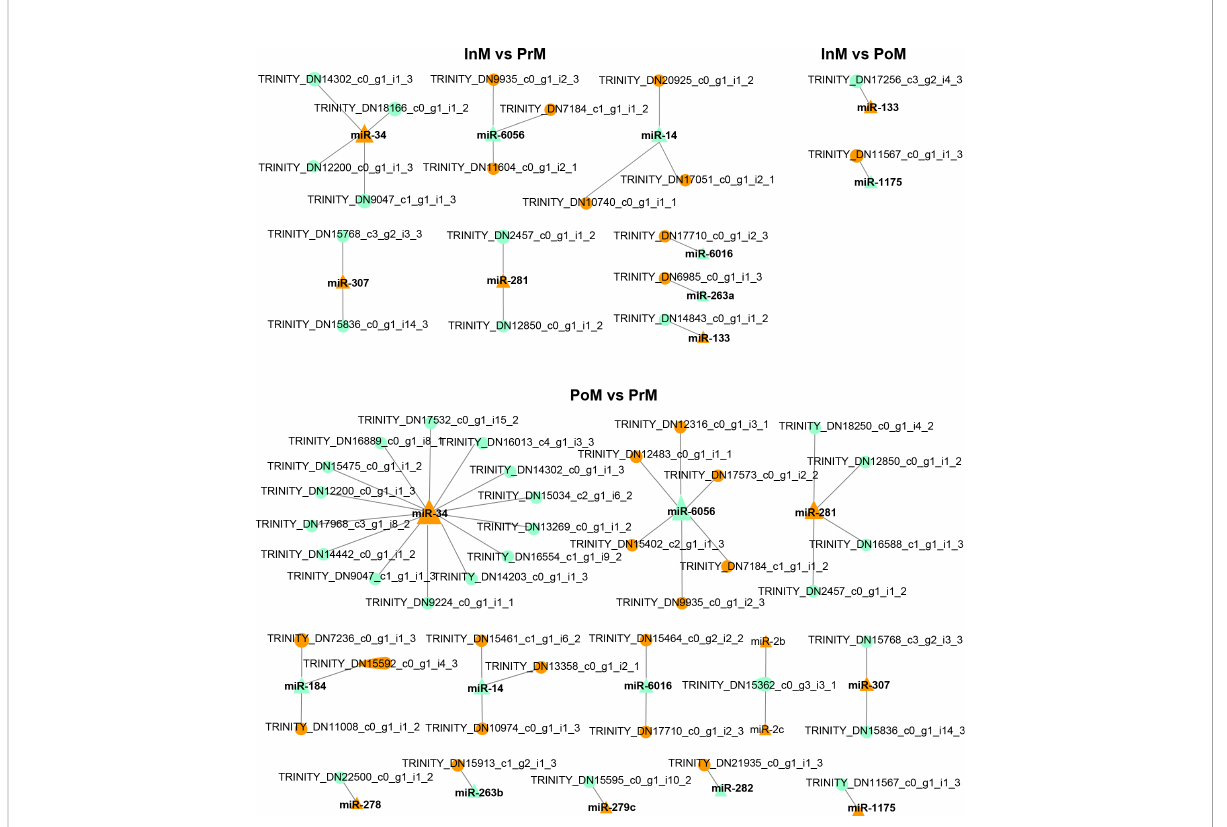
FIGURE 8 Interaction analysis of mRNA and EVs miRNAs. The triangles are miRNA, the circles are mRNA, orange color represents upregulated, and light green color represents downregulated, and the size represents connectivity.